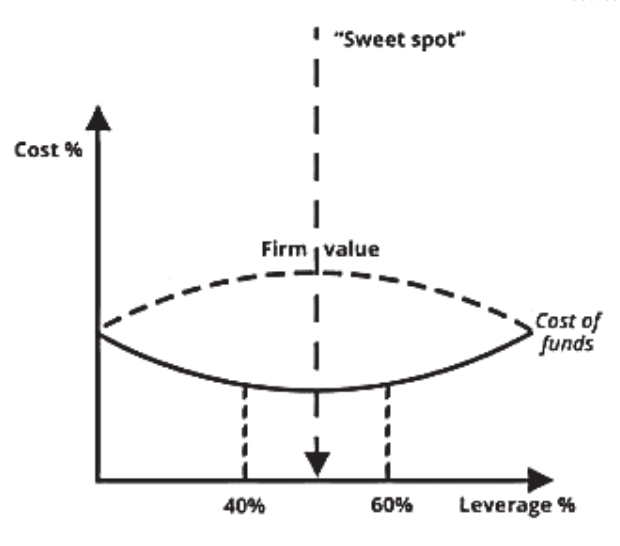
Figure 3. Several scenarios of an increase in the enterprise value with the